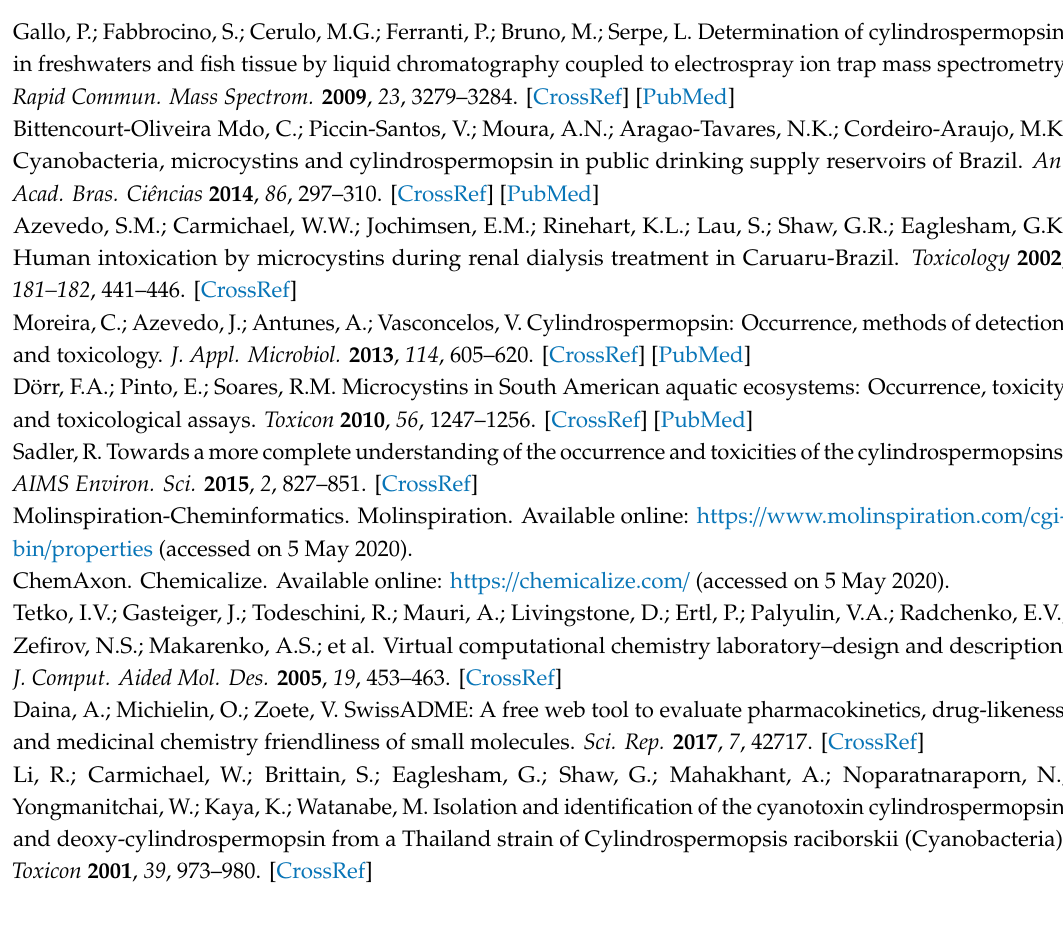
SupplementaryMaterials: The followingare available online. TableS1: Calculated log Pof CYN structuralanalogs according to three di ff erent cheminformatics tools. Figure S1: Sample’s e ffl uent from C18 (red chromatogram) or from GNPC (green chromatogram) cartridges. Figure S2: Sample elution using 5-mL 10% MeOH from C18 (red chromatogram) or from GNPC (green chromatogram) cartridges. Figure S3: Sample elution using 5-mL 50% MeOH from C18 (red chromatogram) or from GNPC (green chromatogram) cartridges. Figure S4: Sample elution using 5-mL 75% MeOH from C18 (red chromatogram) or from GNPC (green chromatogram) cartridges. Figure S5: Sample elution using 5-mL MeOH from C18 (red chromatogram) or from GNPC (green chromatogram) cartridges. Table S2: Percent recovery comparison of CYN, 7D-CYN and 7D-desulfo-CYN on GNPC cartridges using two elution techniques: MeOH:CH 2 CL 2 (4:1) 5% FA using the cartridge on the usual forward mode (3 fractions of 5 mL) or 10%, 50% and 100% MeOH on cartridge-backflush mode (3 fractions of 5 mL). Figure S6: Sample’s e ffl uent from a GNPC cartridge acquired on a LC-DAD-MS 2 . Figure S7: Assay linearity in liquid medium samples analyzed on a LC-DAD. Table S3: Selected analytical performance parameters, criteria and experimental results for the final method. Table S4: Criteria, experimental data and status for within-day precision and bias of 5 levels of quality control liquid medium samples (n = 5). Figure S8: Chromatographic separation of CYN and four similar analytes on a Synergi Hydro-RP (C18) column acquired in a LC-DAD-MS 2